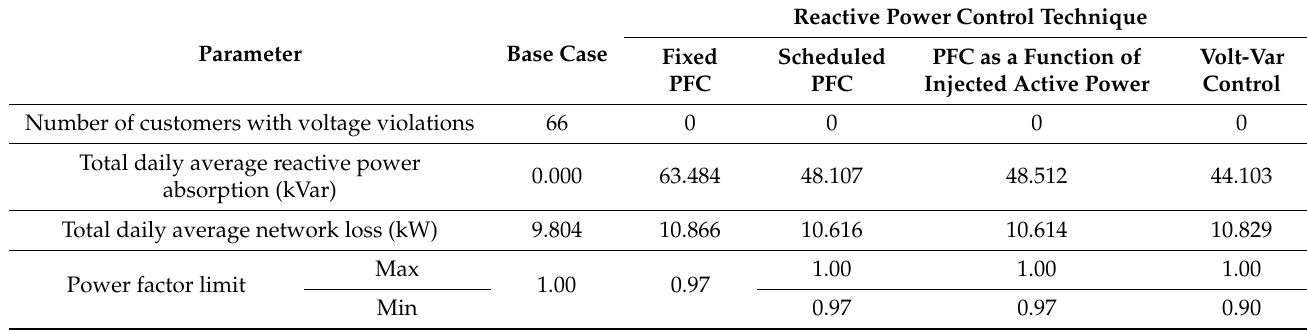
Table 1. Simulation results of the reactive power control